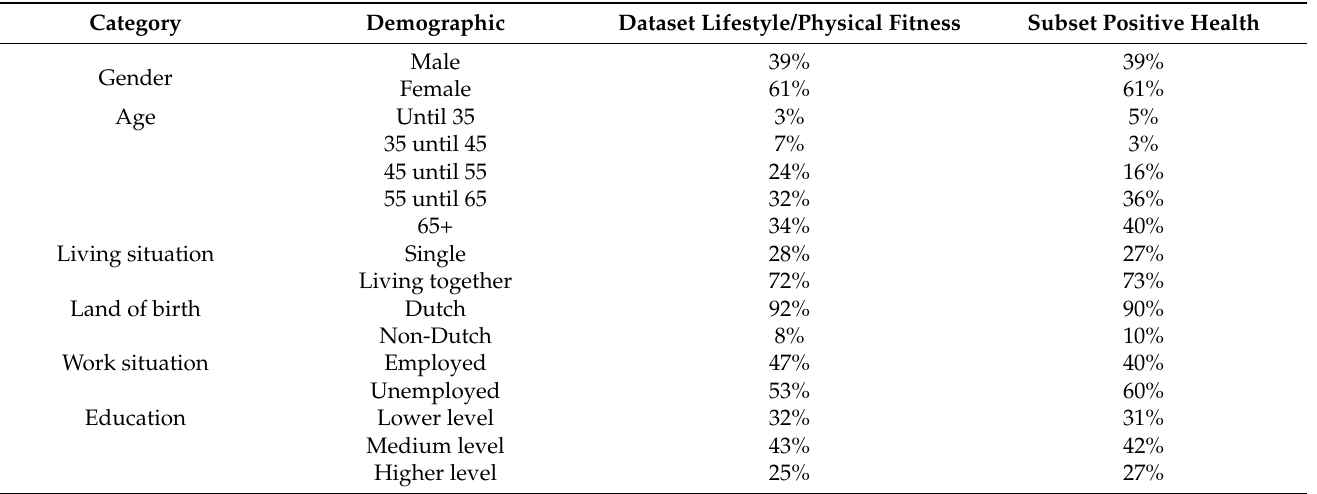
Table A1. Demographics of total dataset versus Positive Health